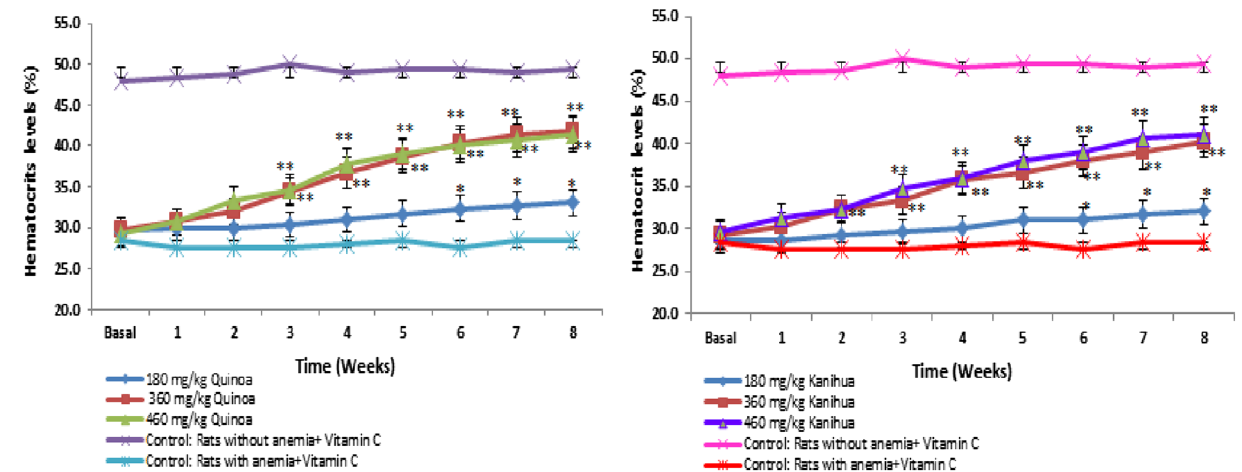
increased hematocrit levels to levels close to control rats with‑ out anemia. Each point represents the mean ± SEM of three rats, * p ≤ 0.05, ** p ≤